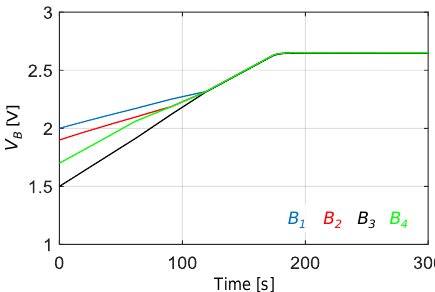
Figure 13. EDLC cell voltage, charged by the CC-CV charger with the cells-to-cells balancer.